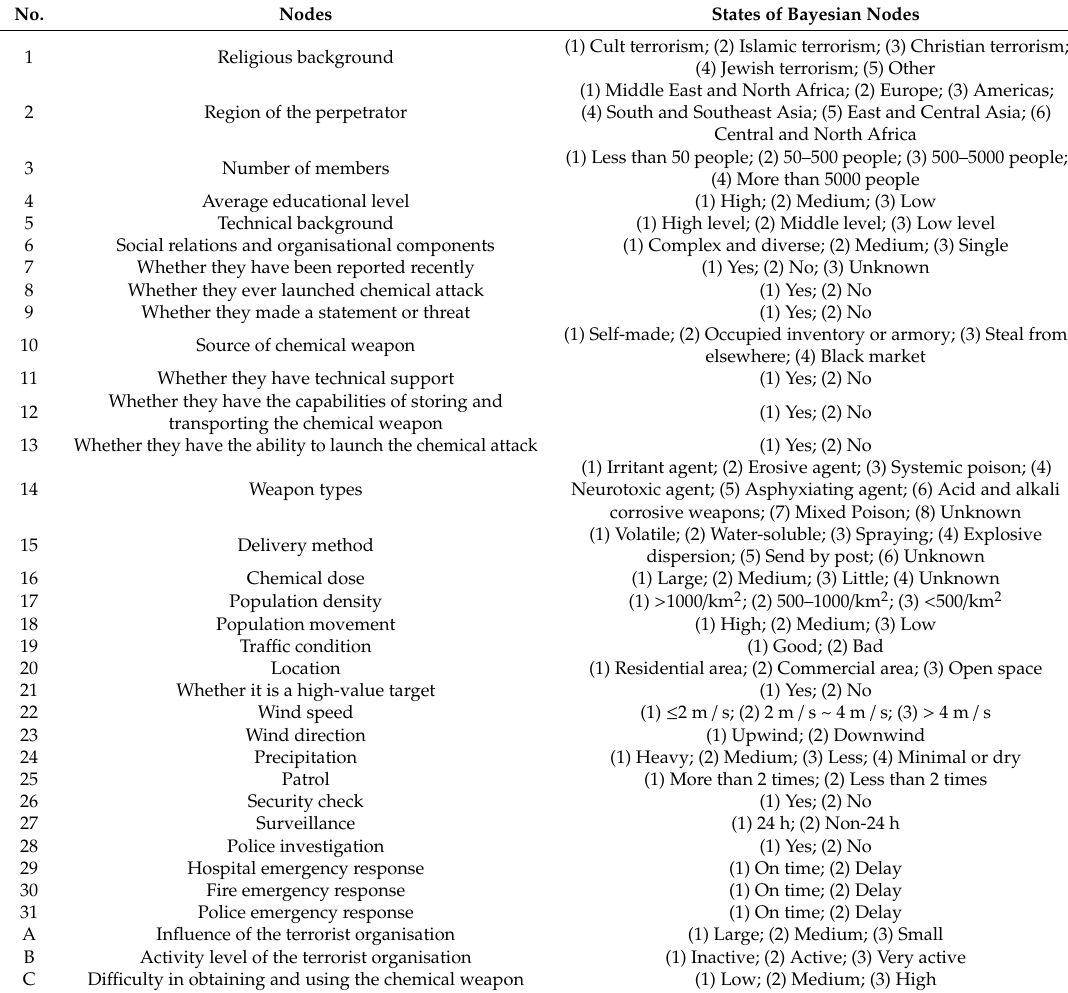
Table 1. States of Bayesian Network (BN)